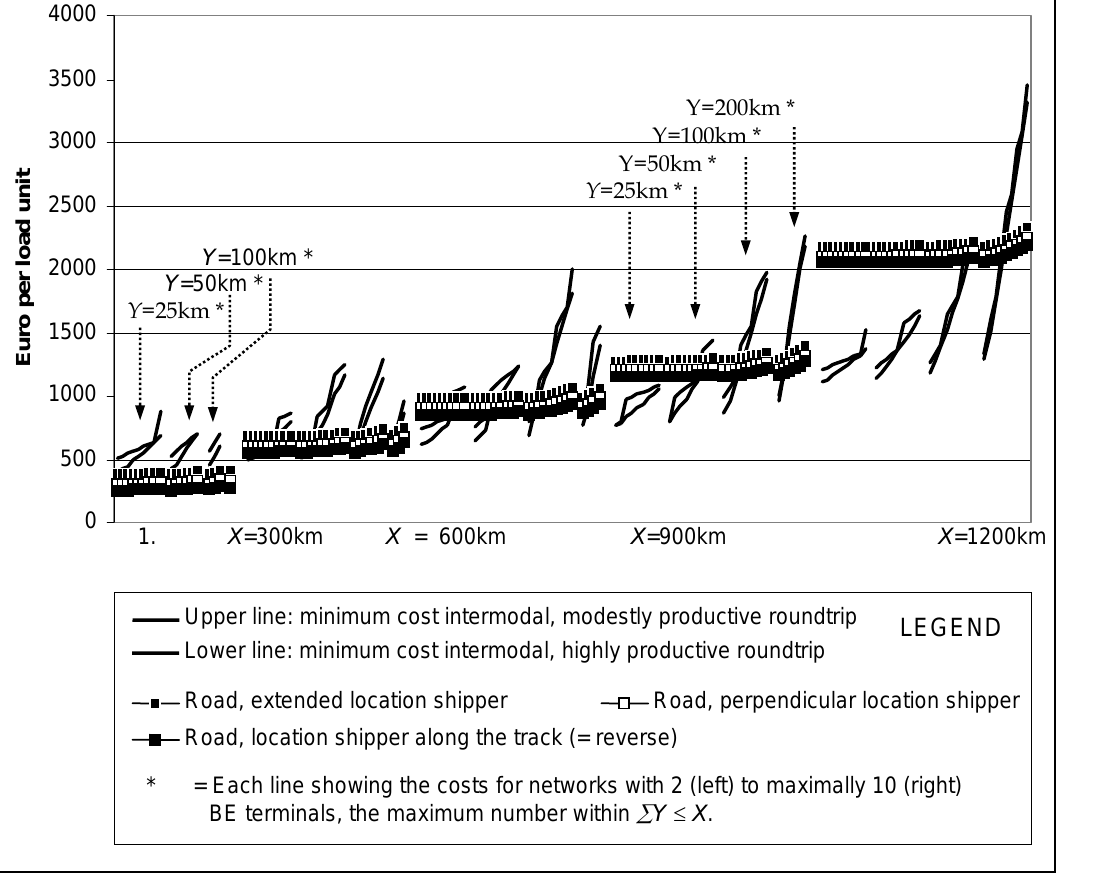
Figure 7. Competitiveness of lowest cost bundling networks relative to road transport. Network transport volume = 14.000 LUs/y